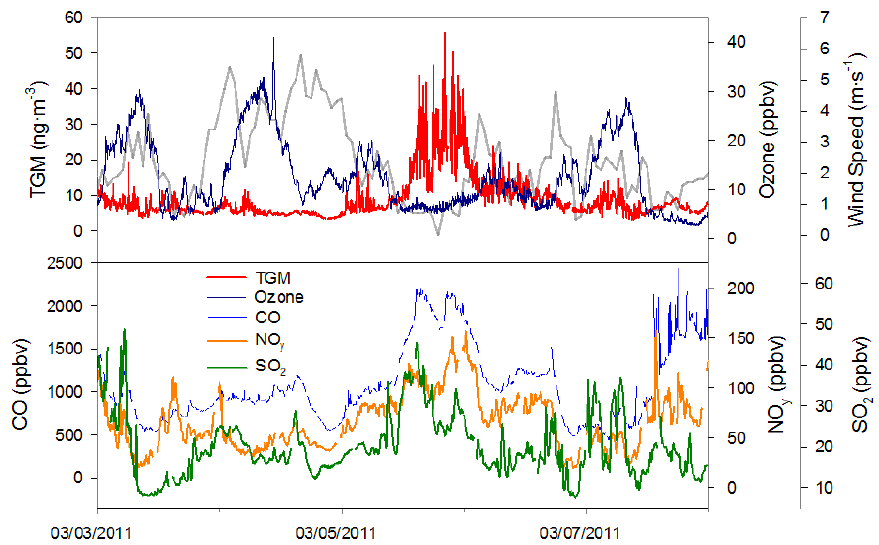
Figure 15. Time series of TGM, O 3 March 2011 through 7 March 2011. This represents episode #5 in Table